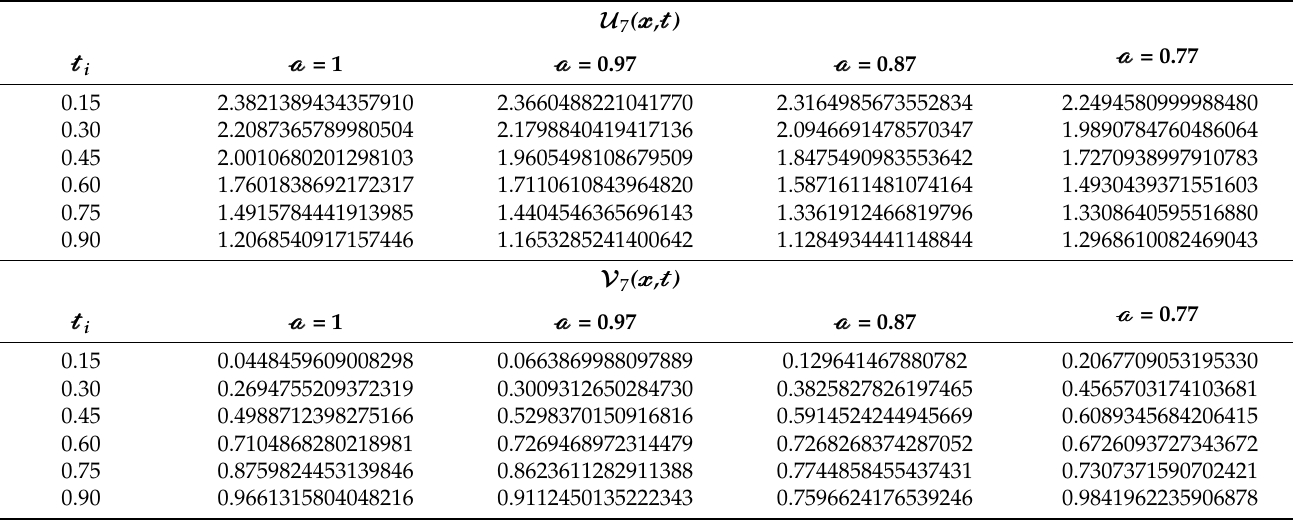
Table 4. Numerical results of approximated solutions, at n = 7, 𝓍 = 1, and different values of 𝒶 , for